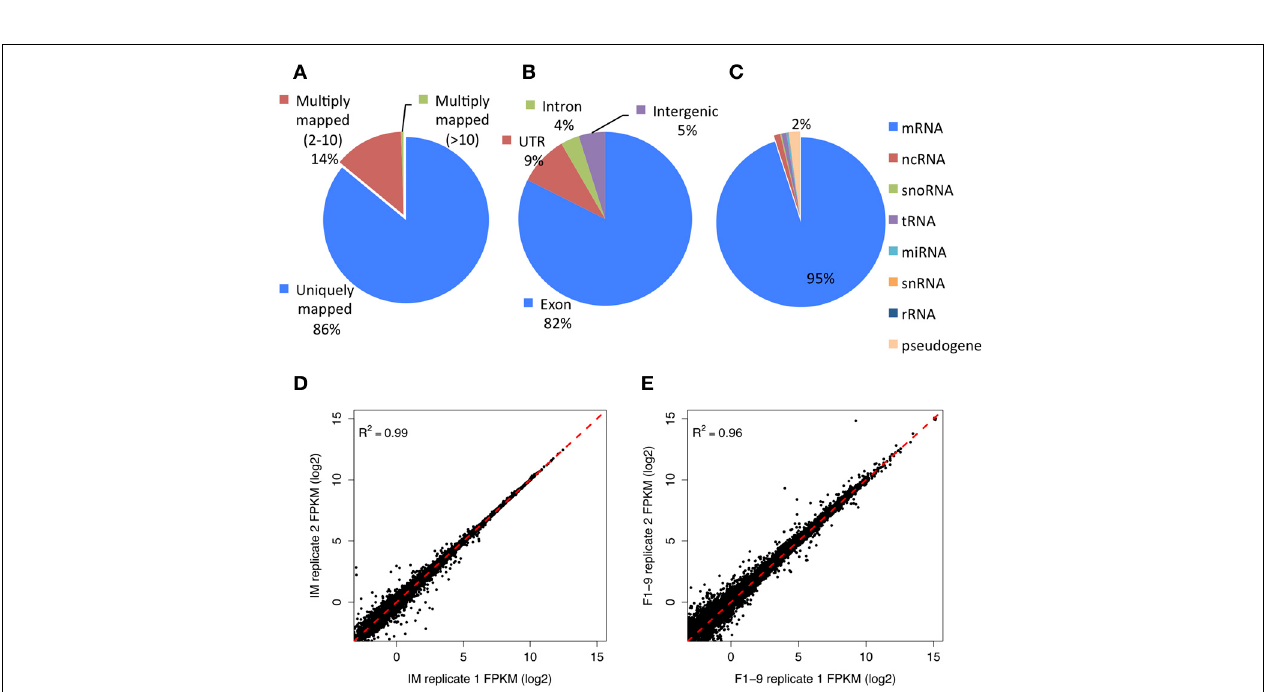
FIGURE 1 | The details of reads mapping and reproducibility of RNA-Seq data. (A) Distribution of aligned reads, which are mapped either uniquely or to multiple positions on the genome. (B) Percentage of reads distributed to exons, introns, and untranslated or intergenic regions. (C) Classification of detected genes by annotated genomic features